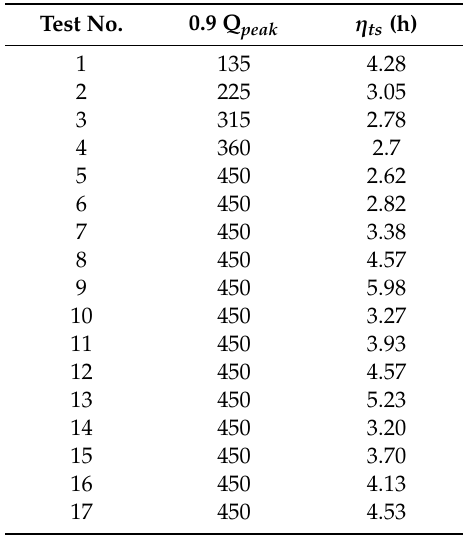
Table 2. Time span for each test when discharge exceeded 90% of peak discharge. Test No.